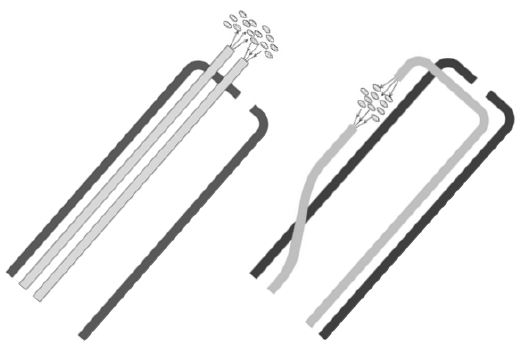
Figure 2. Reflection ( left ) and transmission ( right ) fiber-optic intravenous blood oximeters. The emission and measuring optic fibers are drawn in grey, the catheter wall is drawn in black.